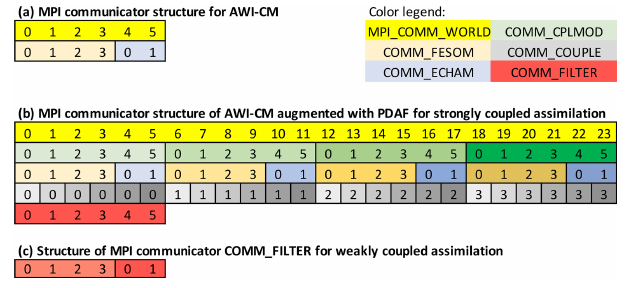
Figure 3. Example configuration of MPI communicators: (a) AWI- CM, (b) AWI-CM with PDAF extension for ensemble data as- similation. The colors and lines mark processes that are grouped as a communicator. Different shades of the same color mark the same communicator type (e.g., four orange communicators COMM_FESOM). For COMM_COUPLE, each communicator is spread over the model tasks. The numbers mark the rank index of a process in a communicator.